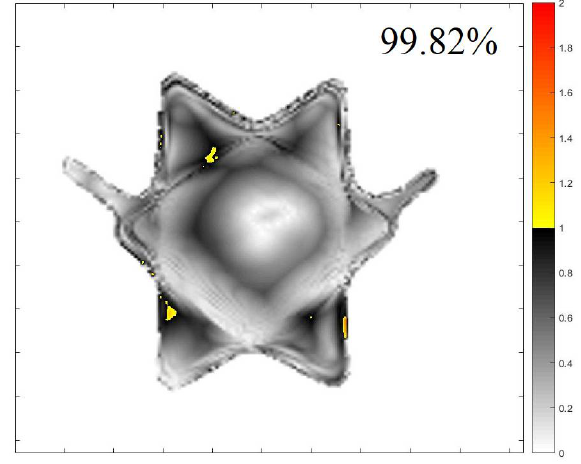
Figure 6. Gamma map index comparing the measured image and calculated image of Figure 9, with 99.82% of approved pixels (z = 5.4 cm) 40% of threshold.